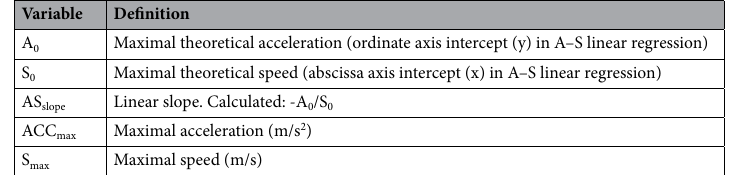
Table 1. Variables of the acceleration-speed